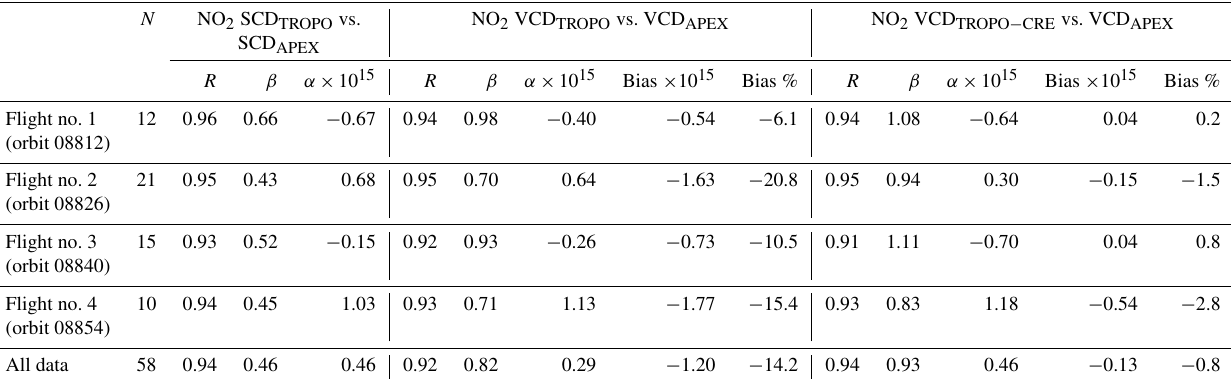
Figure 8. Scatter plots and linear regression analyses of co-located TROPOMI and averaged APEX NO 2 VCD retrievals for the data sets acquired on 26–29 June 2019. Regression lines and statistics are colour coded grey and black for the comparison of NO 2 VCD APEX with NO 2 VCD TROPO and VCD TROPO − CRE , respectively. Note that data points are shown for the comparison of NO 2 VCD APEX with VCD TROPO − CRE only. Vertical error bars indicate the overall errors in NO 2 VCD TROPO , while the horizontal whiskers represent the errors in NO 2 VCD APEX retrievals, averaged over all APEX pixels within the footprint of a co-located TROPOMI pixel. Data points are colour coded based on the number of APEX pixels averaged within a TROPOMI pixel. In panel (a) , TROPOMI pixels are only included in the comparison when they are covered for more than 50% by APEX pixels in order to avoid undersampling, while in panel (b) , as a reference, all TROPOMI pixels having coincident APEX pixels are analysed. Table 4. Correlation statistics between coincident APEX and TROPOMI NO 2 SCD and VCD products (OFFL v1.03.01) for the dif- ferent flights. The last row (“All data”) considers all four data sets together. TROPOMI pixels are only compared with the average of all APEX pixels within the footprint when they are covered for more than 50% by APEX pixels. The NO 2 VCD bias is defined by VCD TROPO ( − CRE ) − VCD APEX and NO 2 VCD relative bias is defined by (VCD TROPO ( − CRE ) − VCD APEX ) / VCD APEX · 100. Alpha ( α ) and beta ( β ) are the intercept and slope of the linear regression